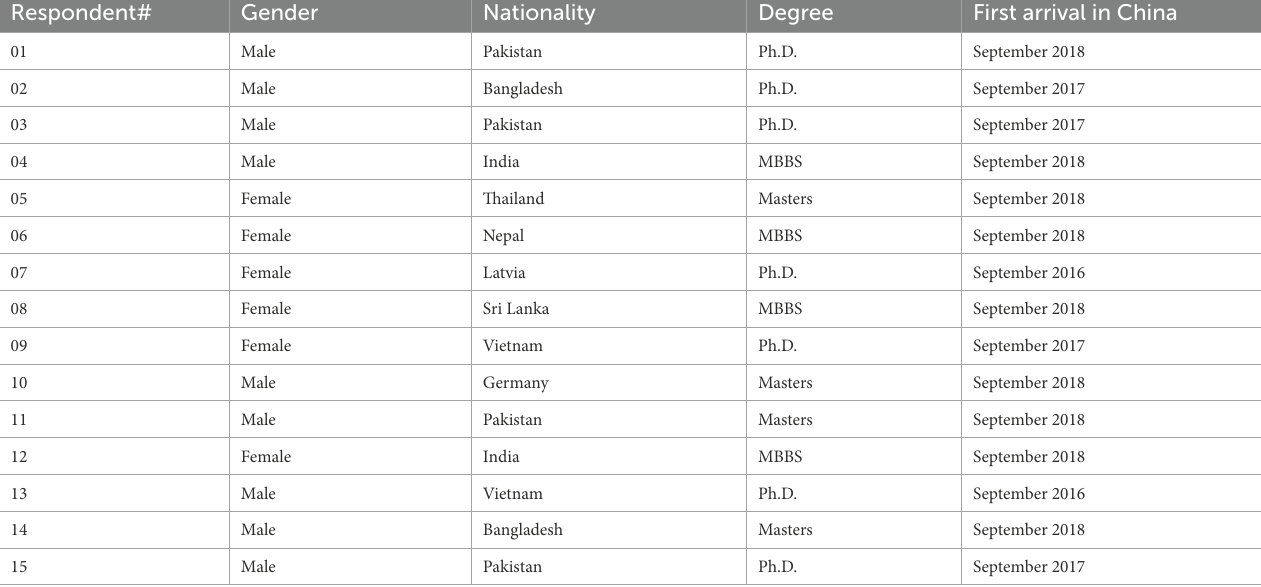
TABLE 2 Demographic characteristics of the respondents who had left China during the